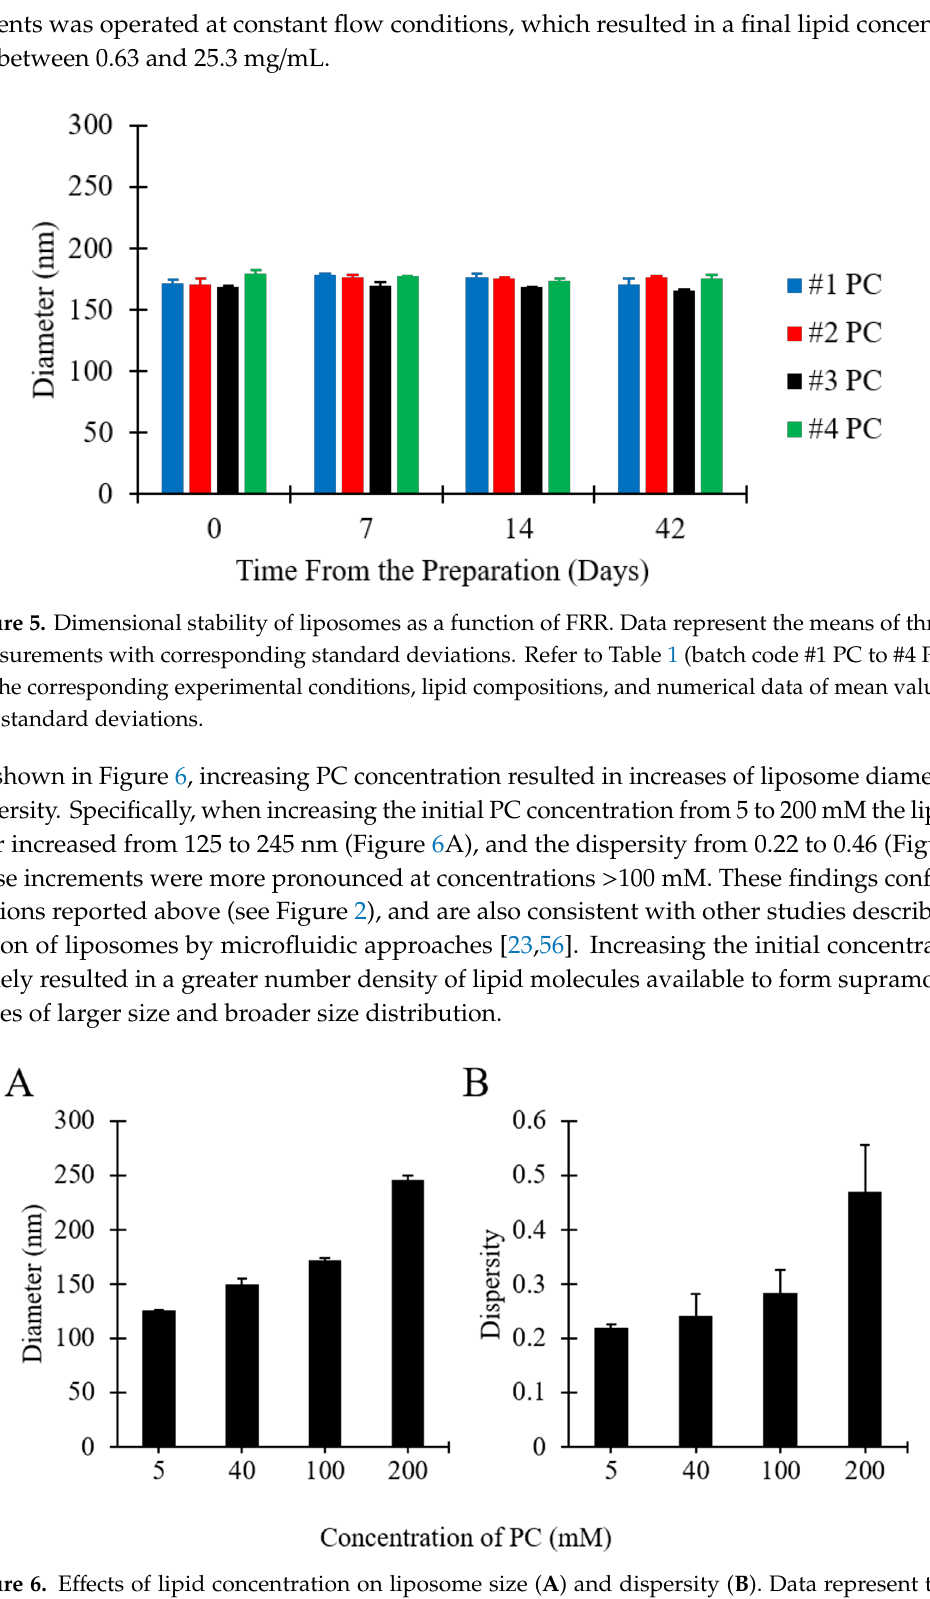
Figure 7. Effects of cholesterol concentration (in the molar range 1:9 to 1:1.5, at a total concentration of 16 mM) on liposome size ( A ) and dispersity ( B ). Data represent the means of three measurements with corresponding standard deviations. Refer to Table 1 (batch code #18 PC to #21 PC) for the corresponding experimental conditions, lipid compositions, and numerical data of mean values and standard deviations. 3.7. The Effects of Liposomes’ Compositions on Their Dimensional Properties Earlier investigations of liposome production by millifluidics have predominately focused on a limited number of model lipid formulations. Since liposomes’ properties are very often dependent